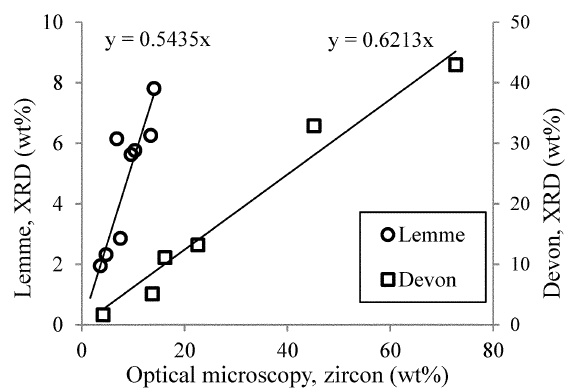
Fig. 3. The mass percentage of zircon in translucent heavy minerals in the 0.05–0.1 mm fraction.